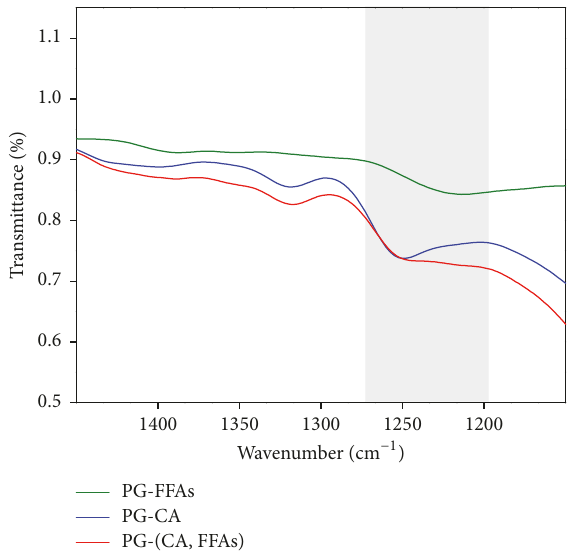
Figure 3: Zoom of the FTIR spectra at 1235–1290 cm −1 of the three synthesized hydrogels. The highlighted C-O vibration is related to the unreacted carboxylic groups.